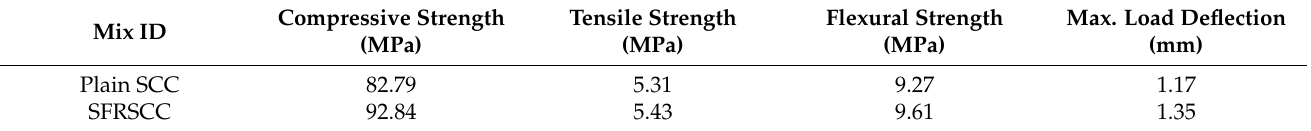
Table 3. Mechanical properties for plain SCC and SFRSCC.